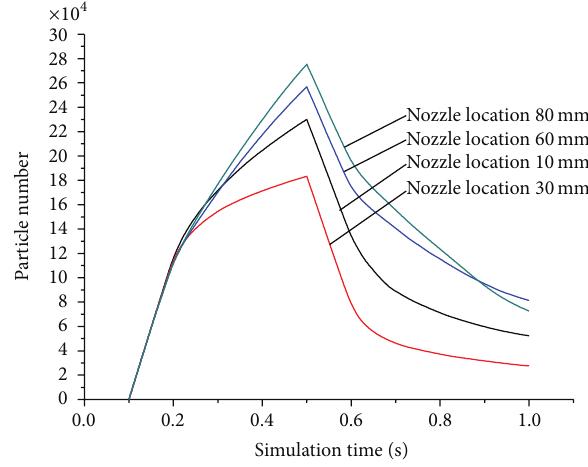
Figure 7: The number of remaining particles in 0.4s feeding